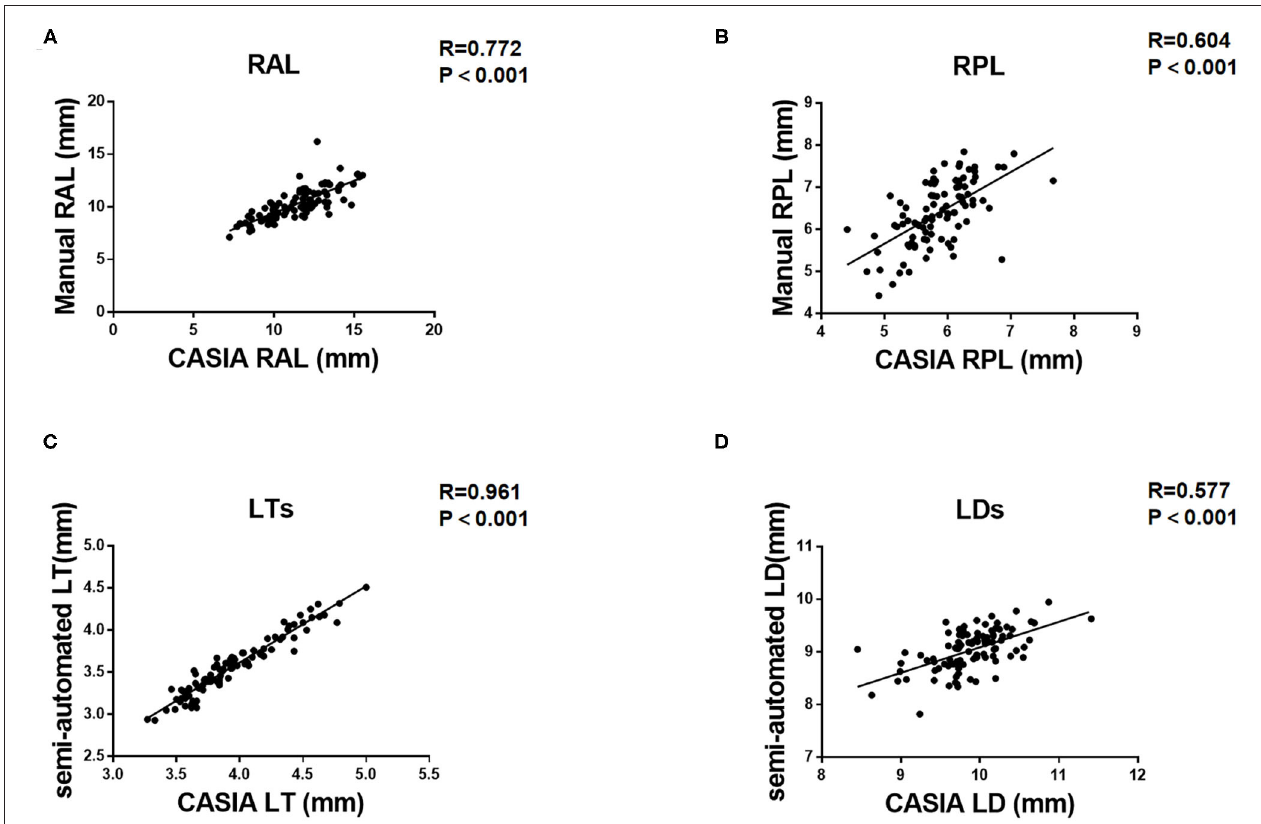
FIGURE 2 | Pearson correlation coefficient ( R ) between Insight 100 and CASIA2 in measuring RAL (A) , RPL (B) , LT S (C) , and LD S (D)